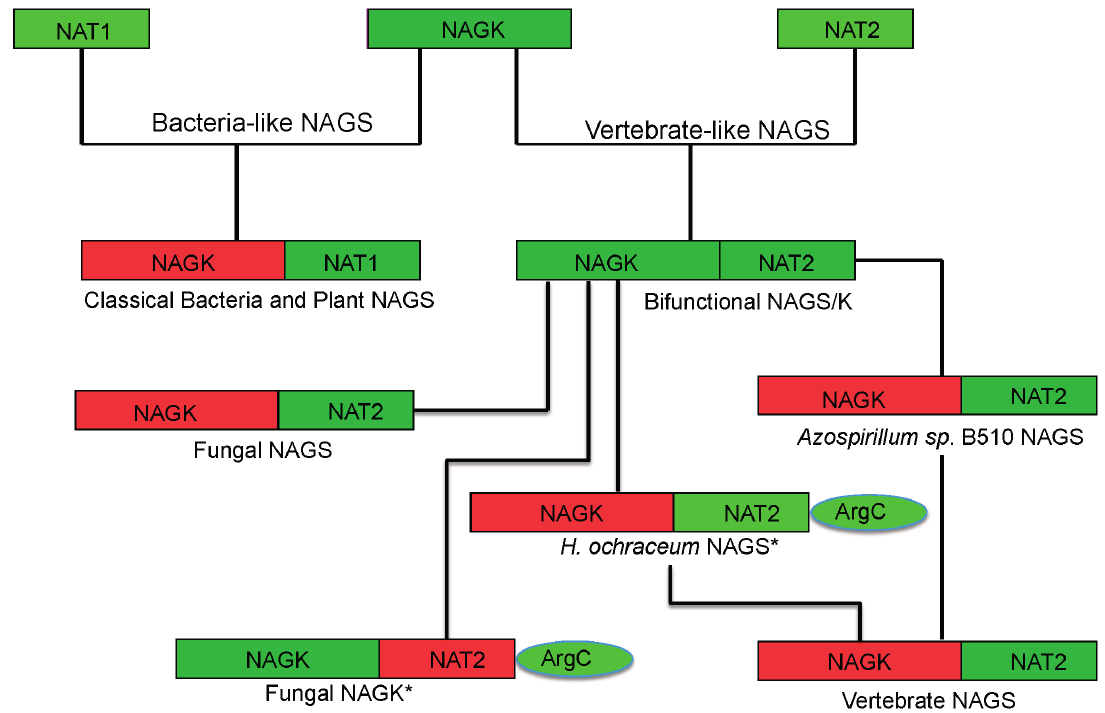
Figure 6. Proposed evolutionary path of the bacteria-like and vertebrate-like NAGS. The domains that have and have not enzymatic activity are colored green and red, respectively. The genes for fungal NAGK and Haliangium ochraceum NAGS (marked with * ) encode a three-domain preprotein, whose mature proteins are formed likely by cleaving the argC